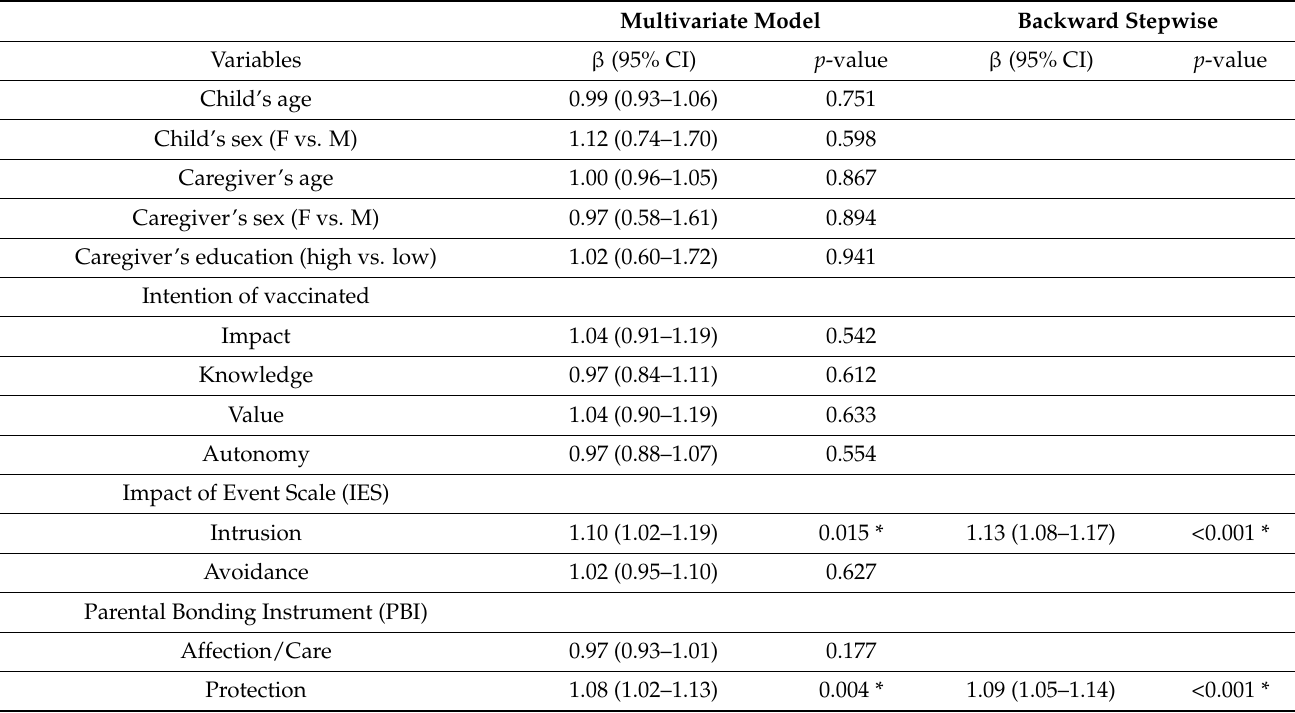
Table 5. Logistic regression of factors associated with psychiatry morbidity among the caregivers of youths who received COVID-19